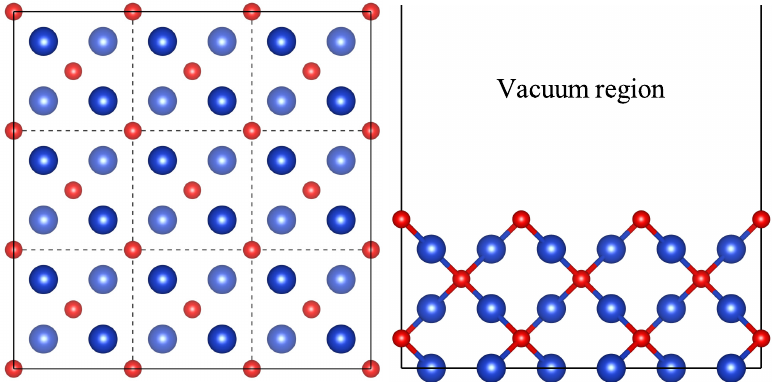
Figure 1. The 3 × 3 × 1 supercell structure for clean Cu 2 O(100) surface. The red and blue spheres represent oxygen atoms and copper atoms,